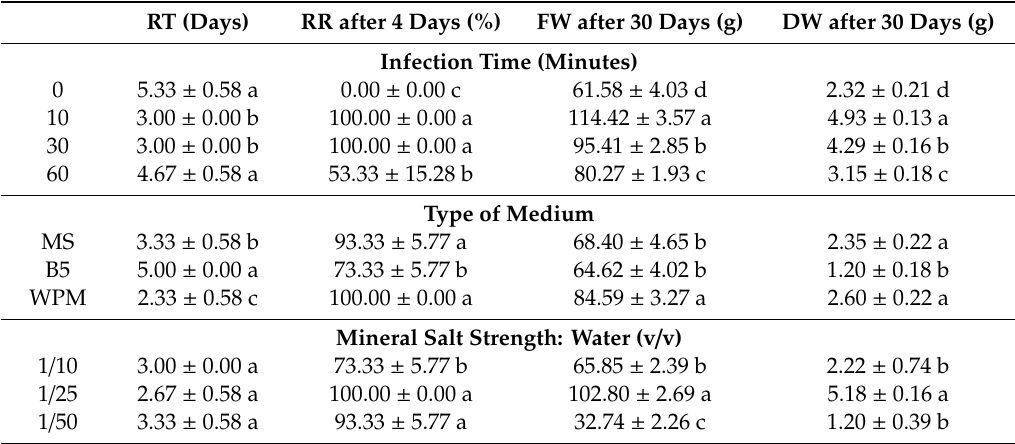
Figure 2. PCR detection of rolB , rolC , and virG . ( A ) PCR amplification of 400 bp fragments of rolB and 600 bp fragments of rolC . The detection of rolB : lane 1 = ladder 100 bp; lane 2 = positive control; lanes 3 and 4 = AHRs; lanes 5 and 6 = negative control of aeroponic roots. Detection of rolC : lane 7 = positive control; lanes 8 and 9 = AHRs; lanes 10 and 11 = negative control of aeroponic roots. ( B ) The